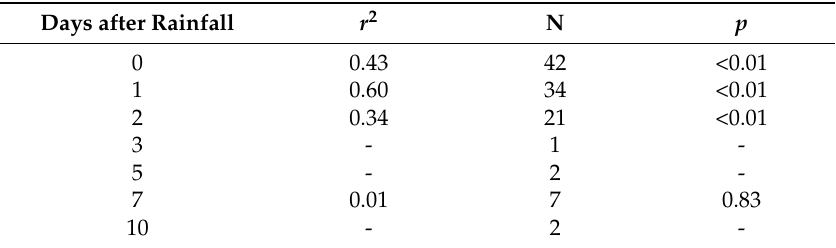
Table 3. Coefficient of determination ( r 2 value), the number of samples/matching pairs (N) of the correlation between turbidity and Band 1 surface reflectance values and the p value, categorised by the days from the last rainfall